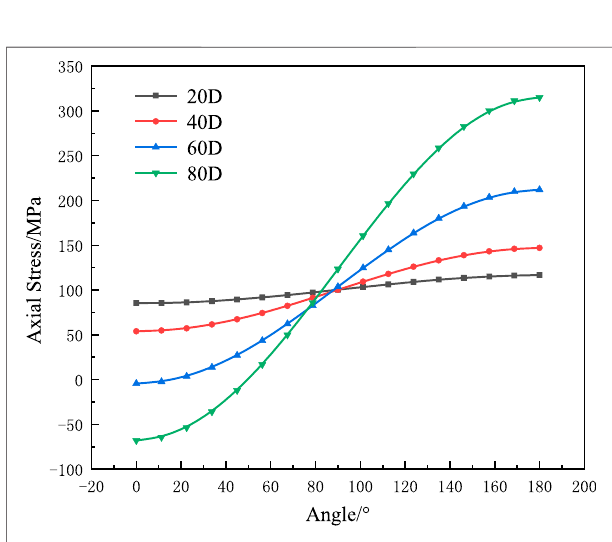
FIGURE 10 | Suspension length effects.